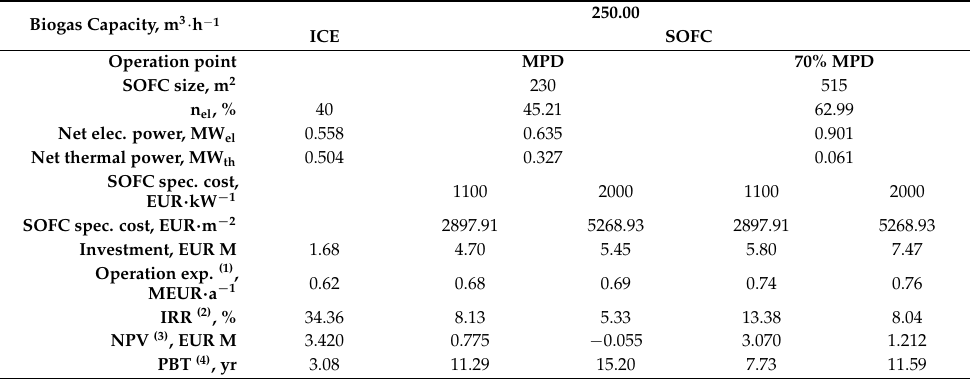
Table 8. Summary of the main operational and economic characteristics, and the feasibility perfor- mance of the smaller scale biogas-CHP